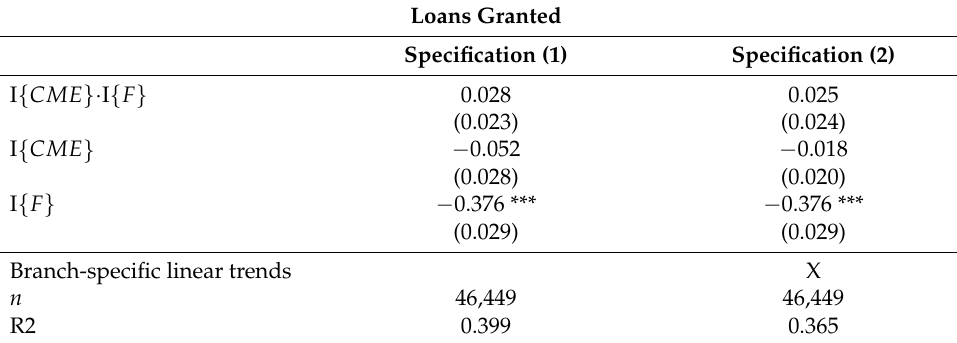
Table 6. Parallel Trends Analysis—Placebo Test on Loans